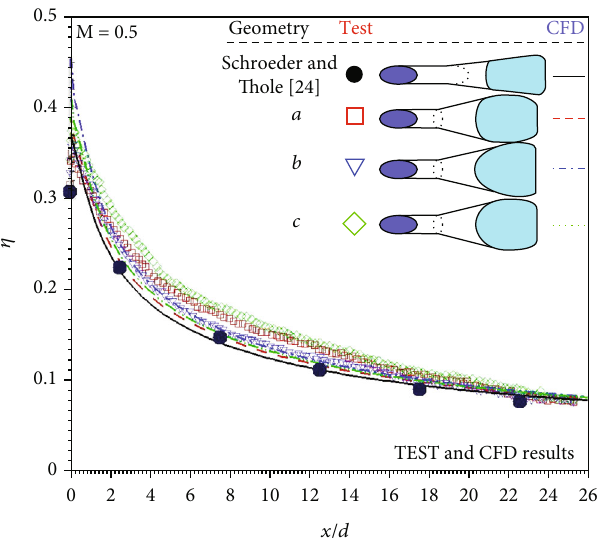
Figure 13: Laterally averaged fi lm e ff ectiveness for M = 0 : 5